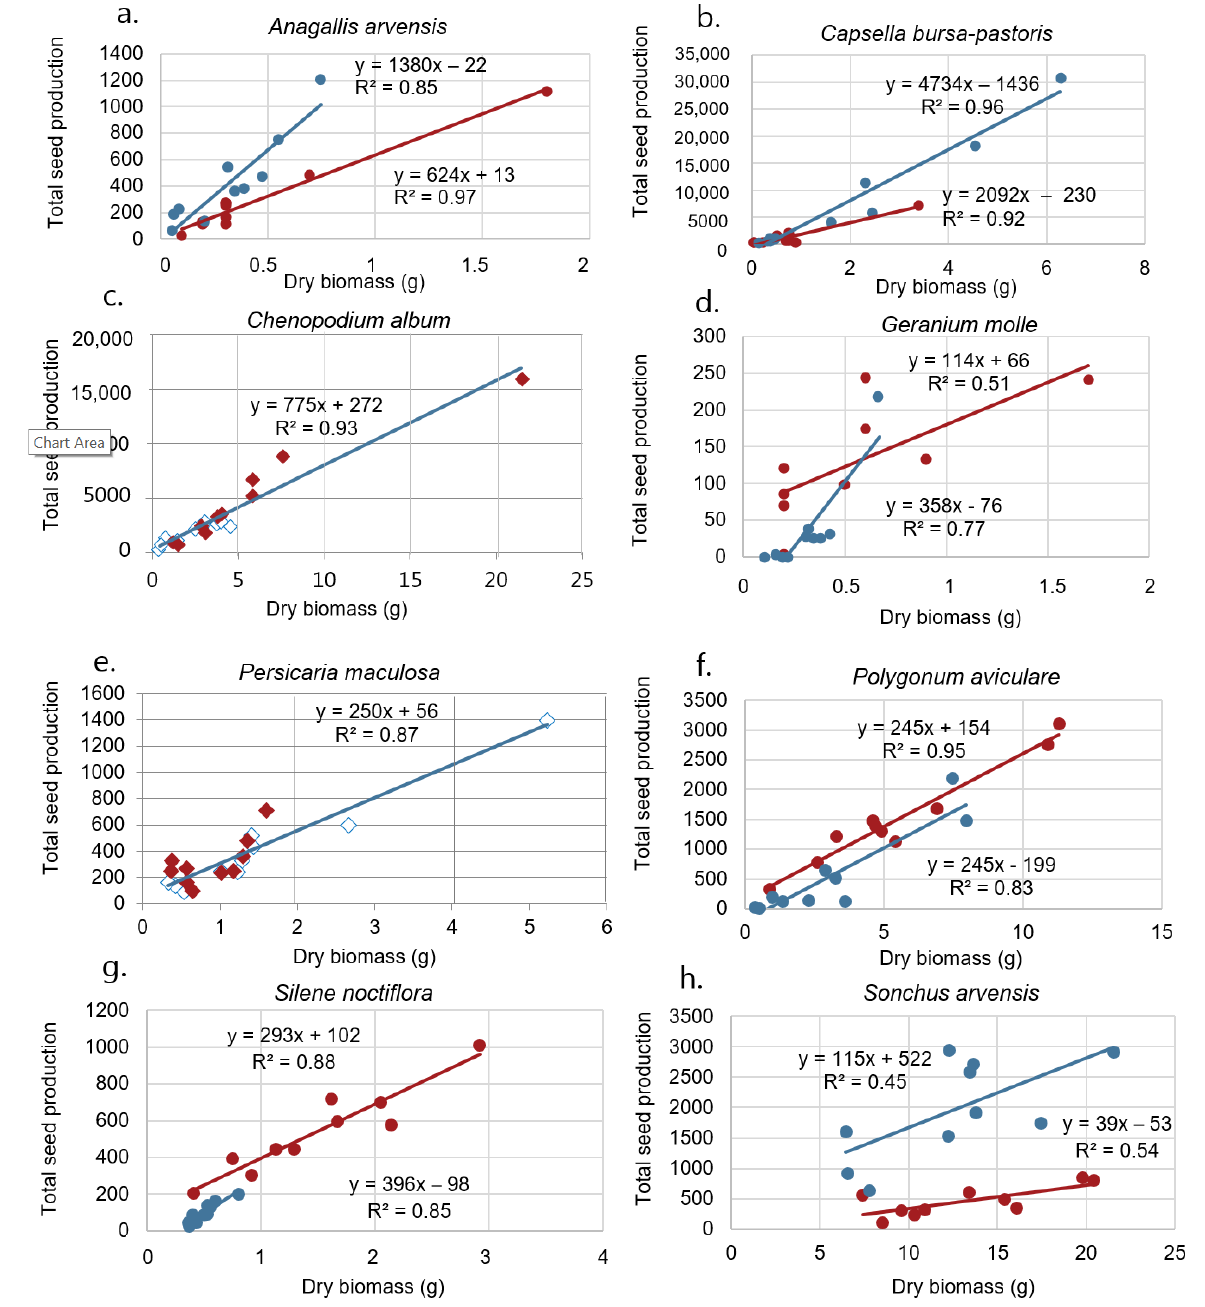
Figure 3. Relationship between plant dry biomass and seed number per plant for ( a ) Anagallis arvensis , ( b ) Capsella bursa-pastoris , ( c ) Chenopodium album , ( d ) Geranium molle , ( e ) Persicaria maculosa , ( f ) Polygonum aviculare , ( g ) Silene noctiflora , and ( h ) Sonchus arvensis. The red points correspond to observations in 2018, and the blue points ( c , e ) correspond to observations in 2017. Regression lines are shown for both years. Where year did not affect the relationship significantly, the data from the two years were pooled together ( c , e ).